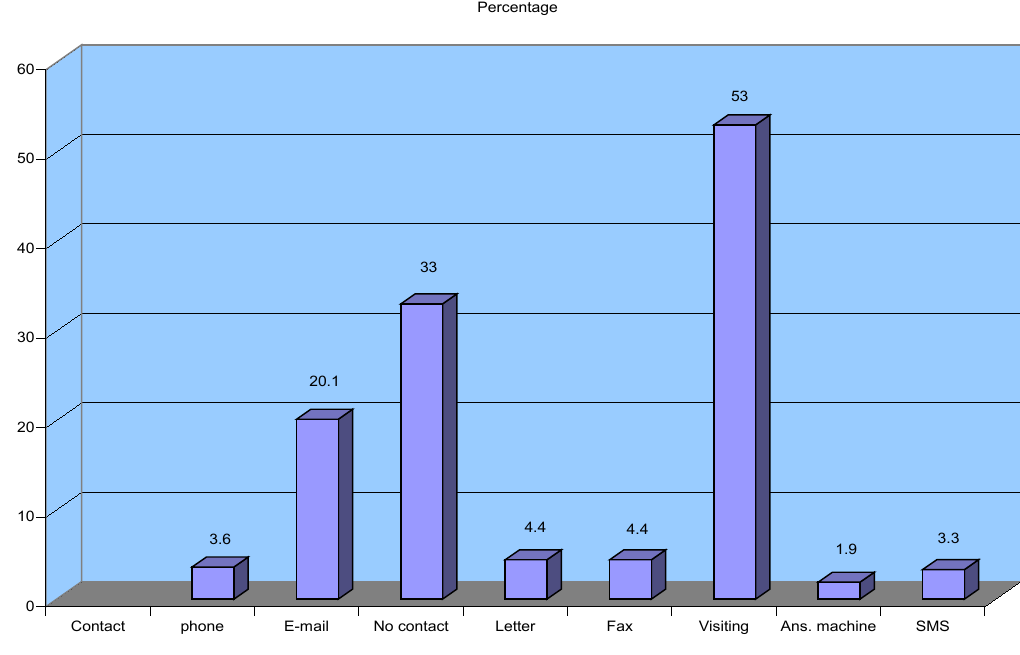
Figure 4. Contacting library/subject